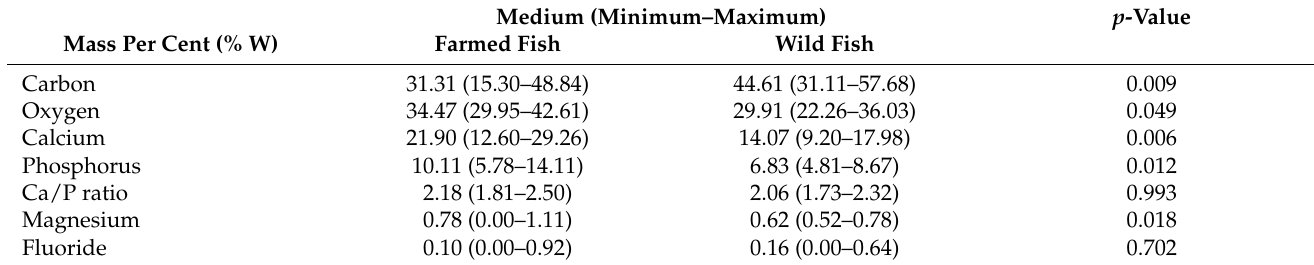
Figure 6. Elemental Microanalysis in the jawbone of rainbow trout (Oncorhynchus mykiss) . ( a ) Farmed fish. ( b ) Wild fish. BSD image, 1000× magnification. Scanning Electron Microscope (Hitachi SU3500, Tokyo, Japan) coupled to XFlash ® Detector 410 and Quantax Esprit 1.8.1 Software controller (Bruker, Germany).